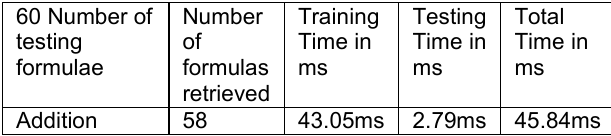
Table 6. The above tabulated value represents time taken for retrieving matched formulae with Tensorflow from a document of 60 samples along with testing time and training